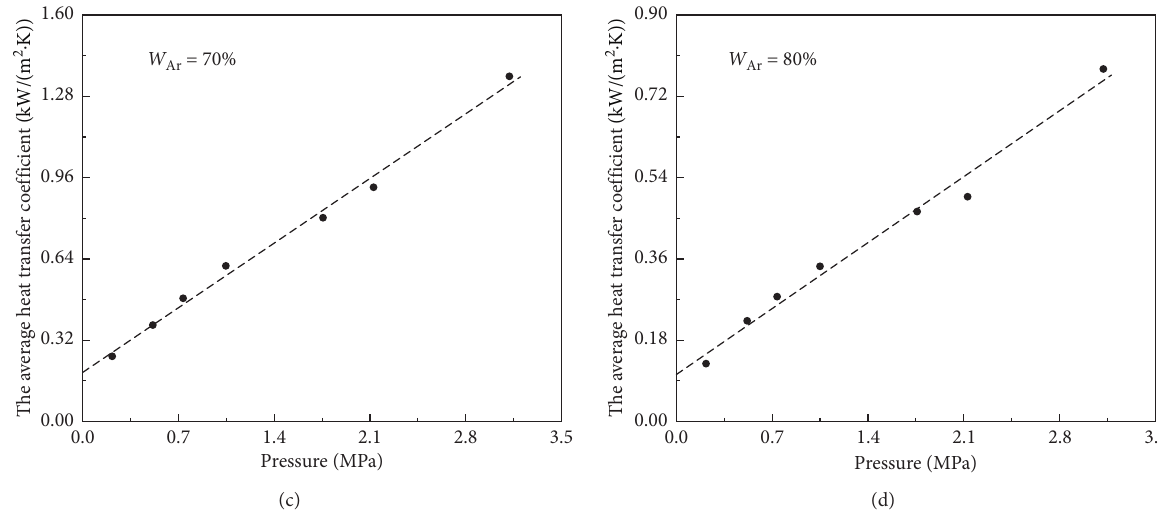
Figure 11: Effect of pressure on the steam condensation with Ar. (a) W